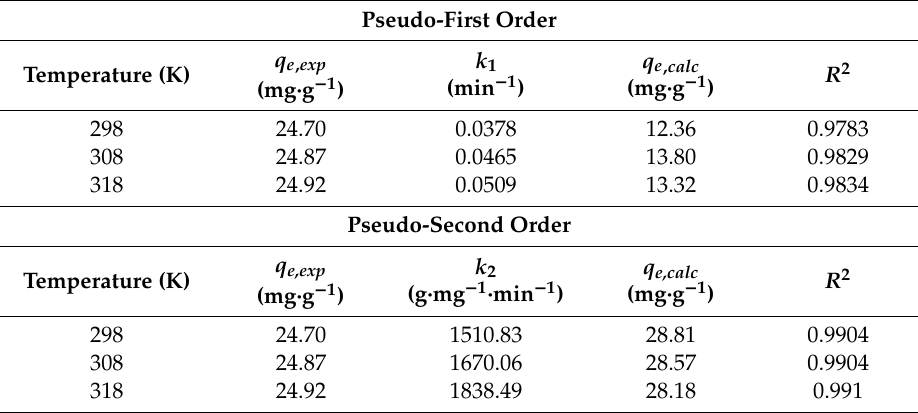
Table 1. Kinetic parameters for the adsorption of cadmium (II) onto Ch-HDTACl at different temperatures.